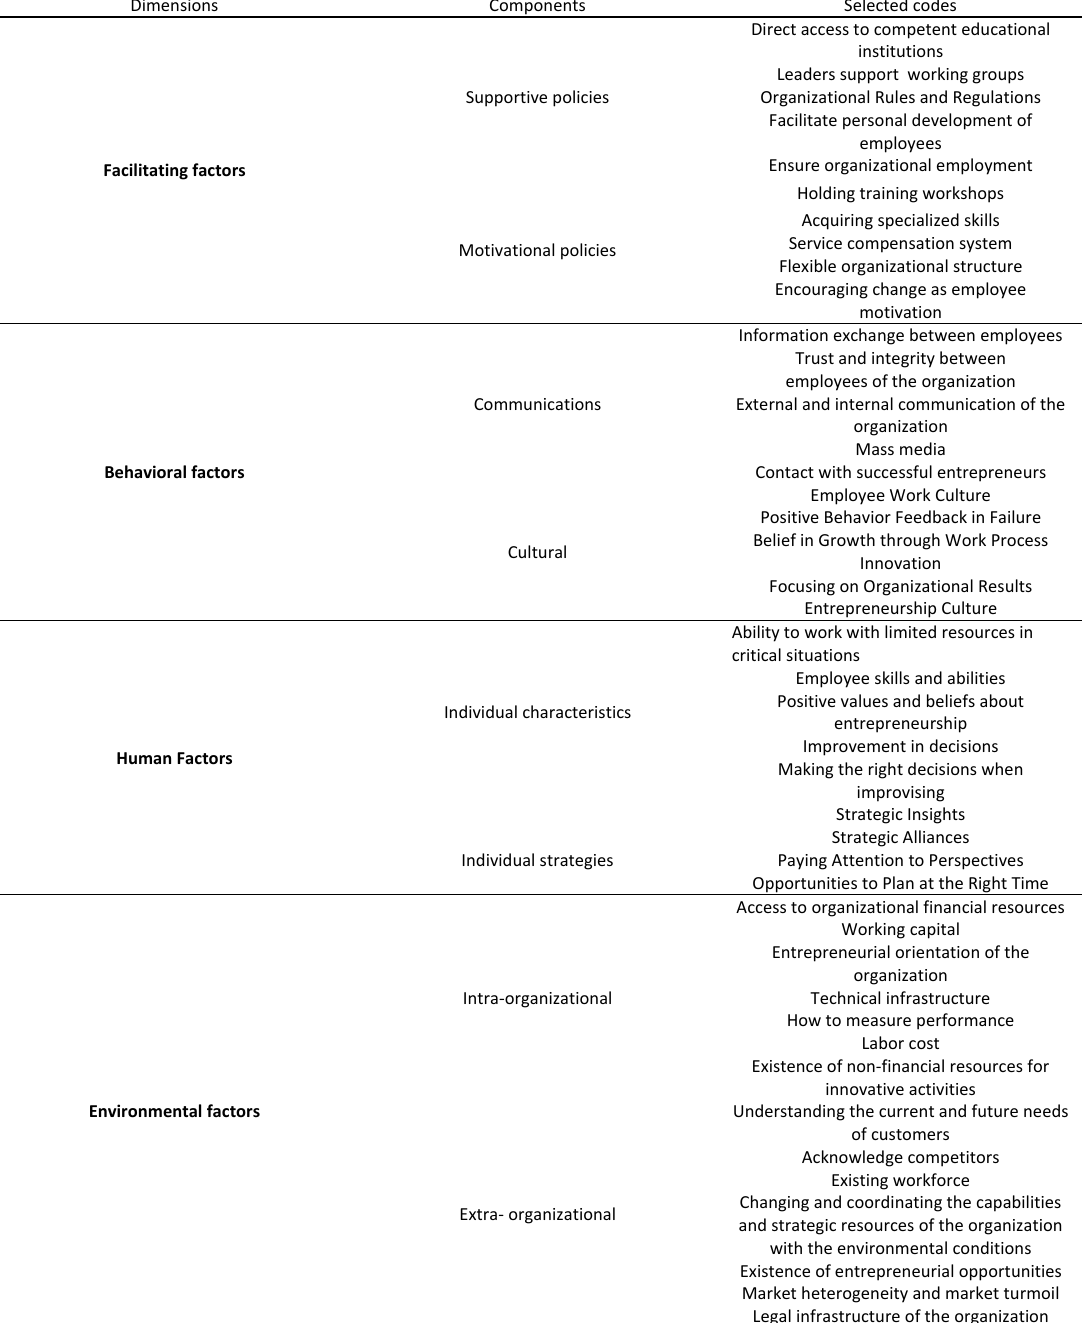
Table 2 Encoding process results Table 2: Encoding process